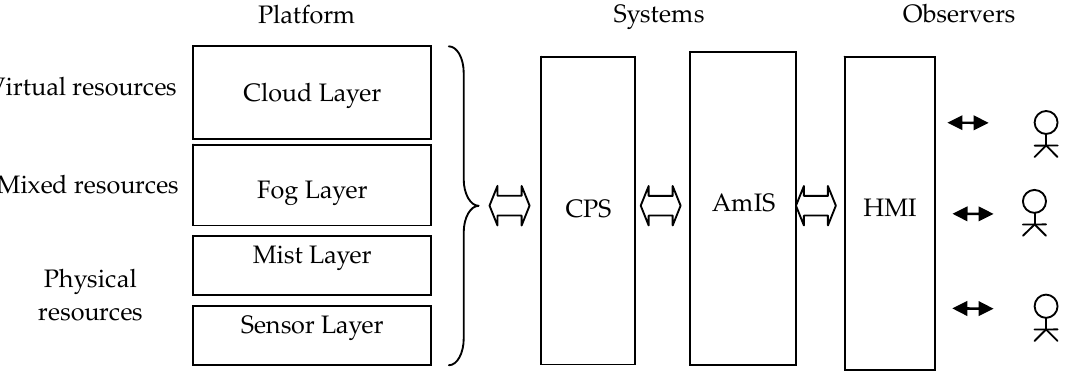
Figure 1. Standard Ambient Intelligence System (AmIS) structure implemented on a fog platform. Users (observers) have different concerns, different rights, and different locations. Different users can communicate with AmIS using different DSLs.